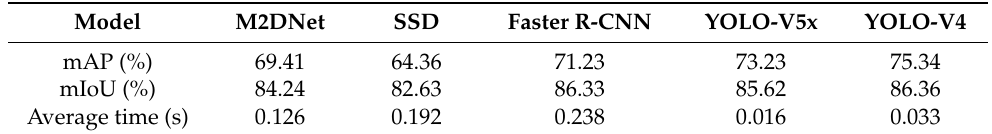
Table 2. Network comparison results.